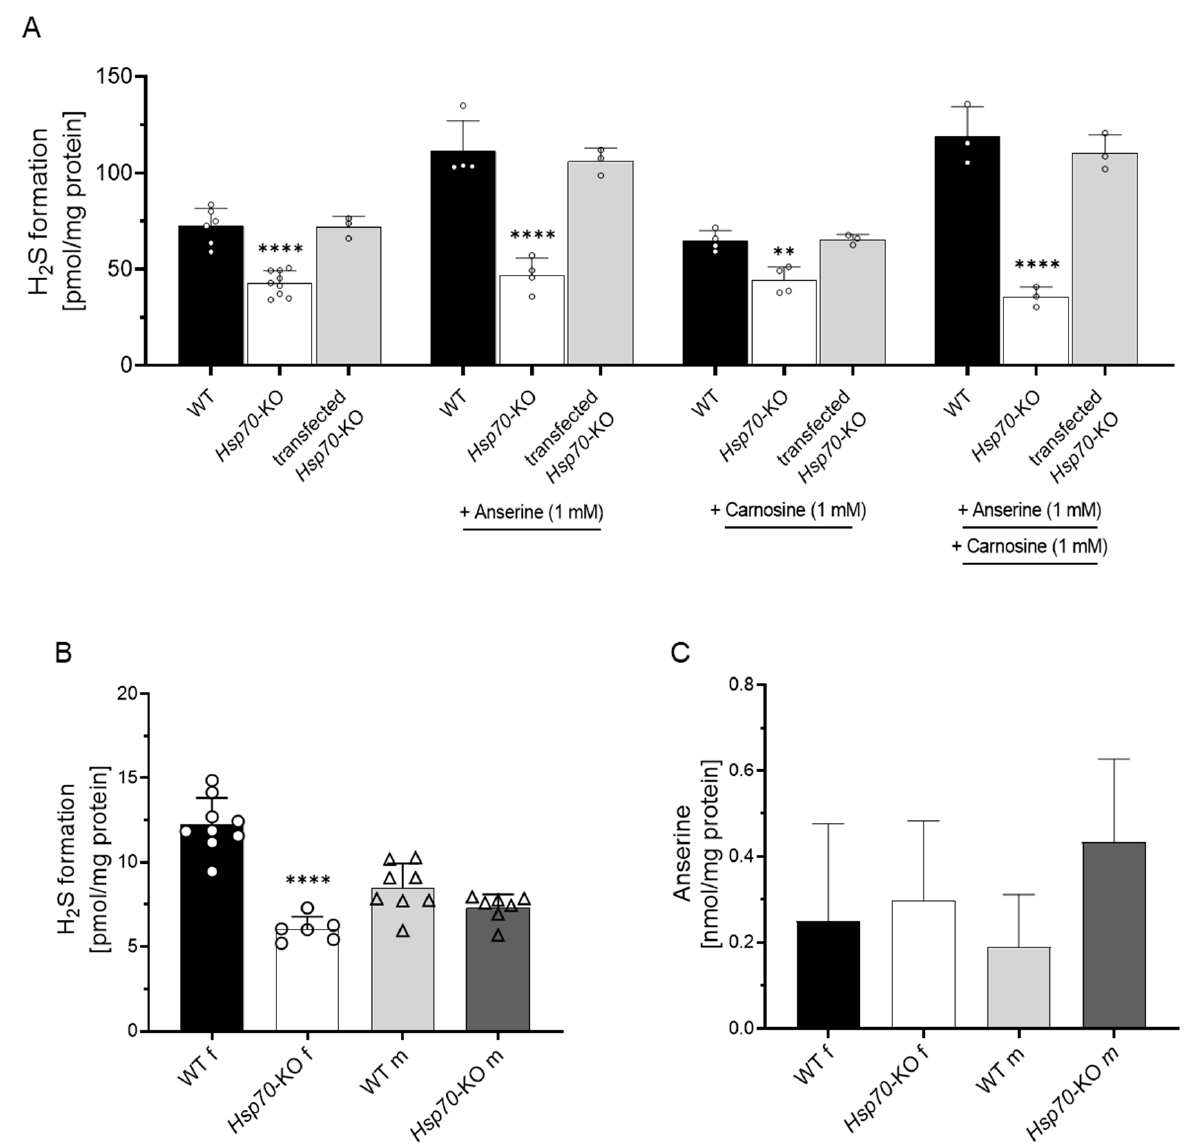
Figure 3. Decreased H 2 S formation in Hsp70 knockout MCEC and mice. ( A ) H 2 S formation was lower in Hsp70 -KO MCEC compared to WT MCEC; Hsp70 -transfection restored H 2 S formation. ( B ) Renal H 2 S formation was lower in female Hsp70 -KO compared to female WT mice. ( C ) Renal anserine concentrations were similar in all four groups. **: p < 0.01; ****: p < 0.0001 (one-way ANOVA with Tukey’s test).